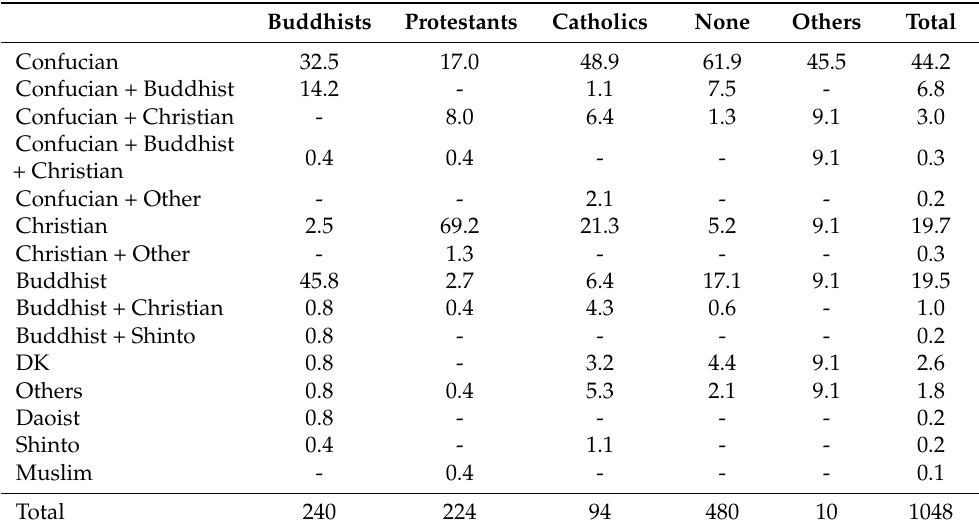
Table 5. Religion associated with rites for deceased family members by religious group (%), 2018